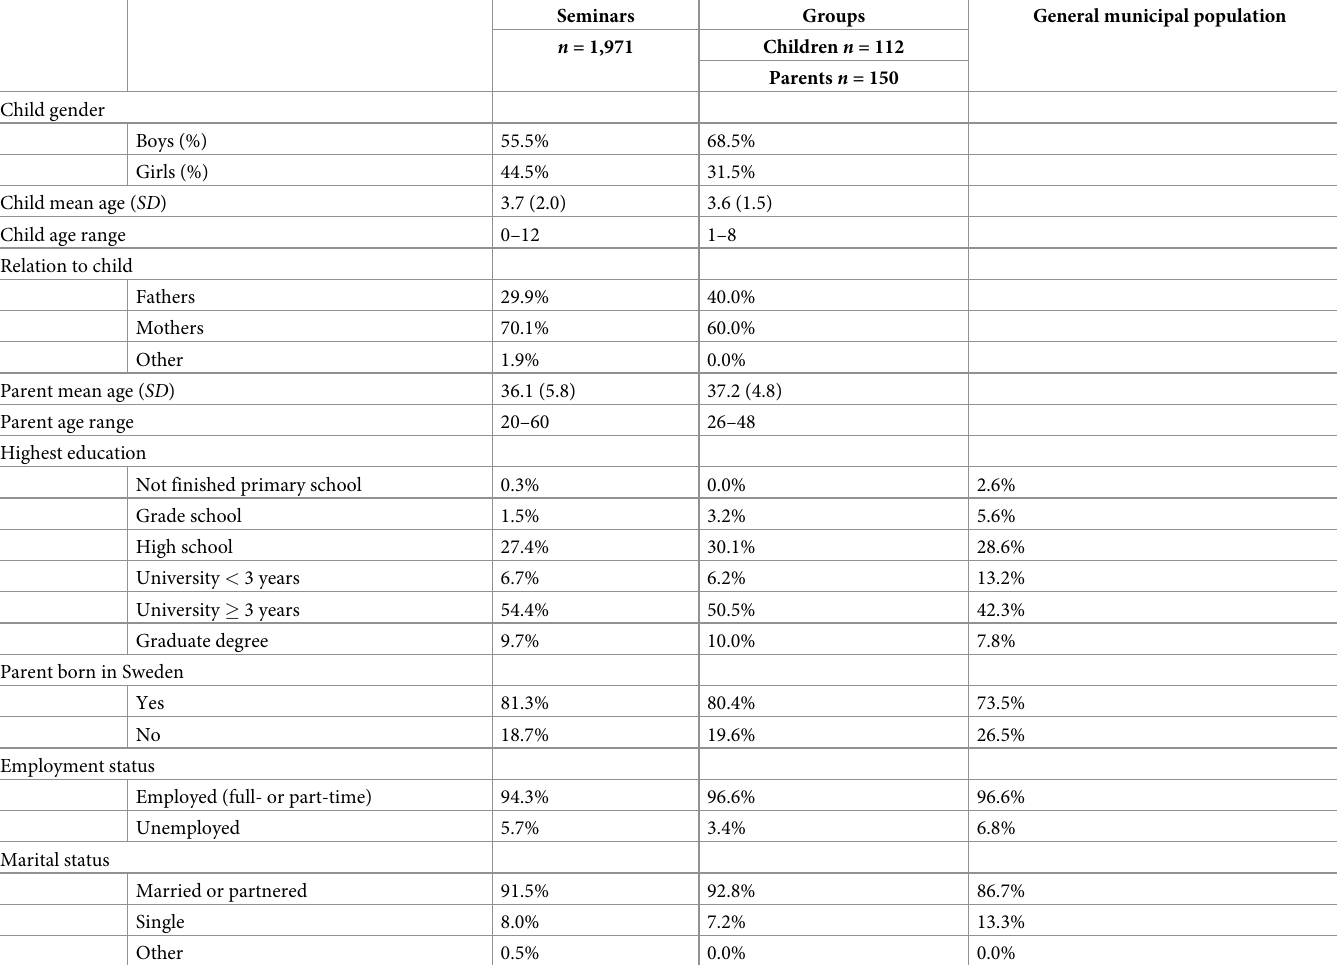
Table 1. Age, gender distributions and basic demographic characteristics of children and parents during